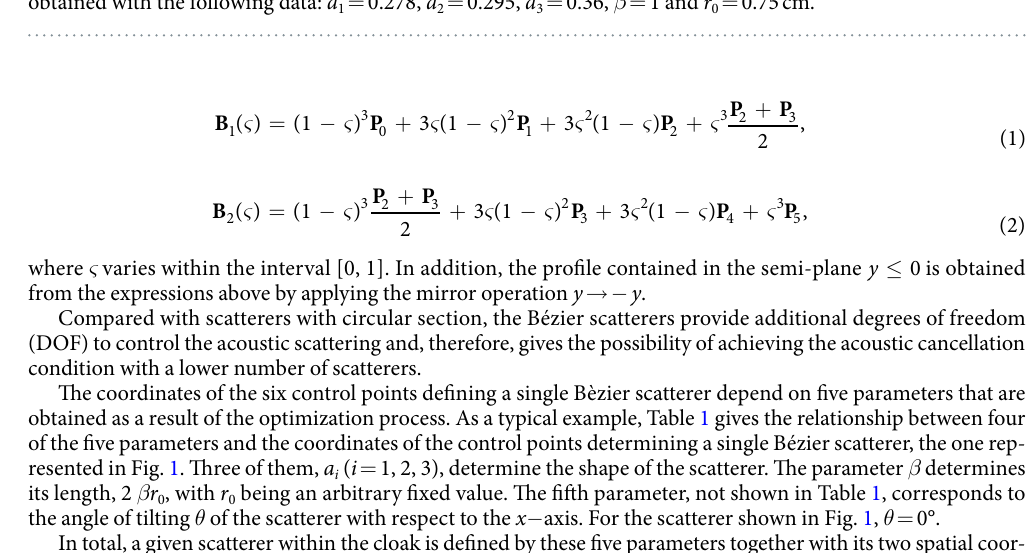
Table 1. Cartesian coordinates of the six control points, P i , employed in the construction of the Bézier scatterer shown in Fig. 1. They are given in terms of the parameters employed in the optimization process: a 1 , a 2 and a 3 are the shape parameters, β is a scale factor and r 0 is an arbitrarily fixed value. The blue curve in Fig. 1 is obtained with the following data: